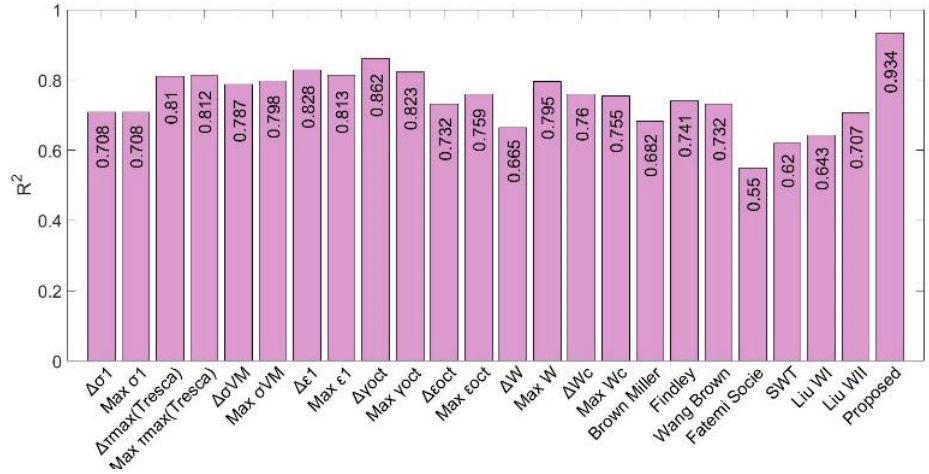
Figure 16. R 2 correlation parameter for each fatigue parameter used for NBR tests.